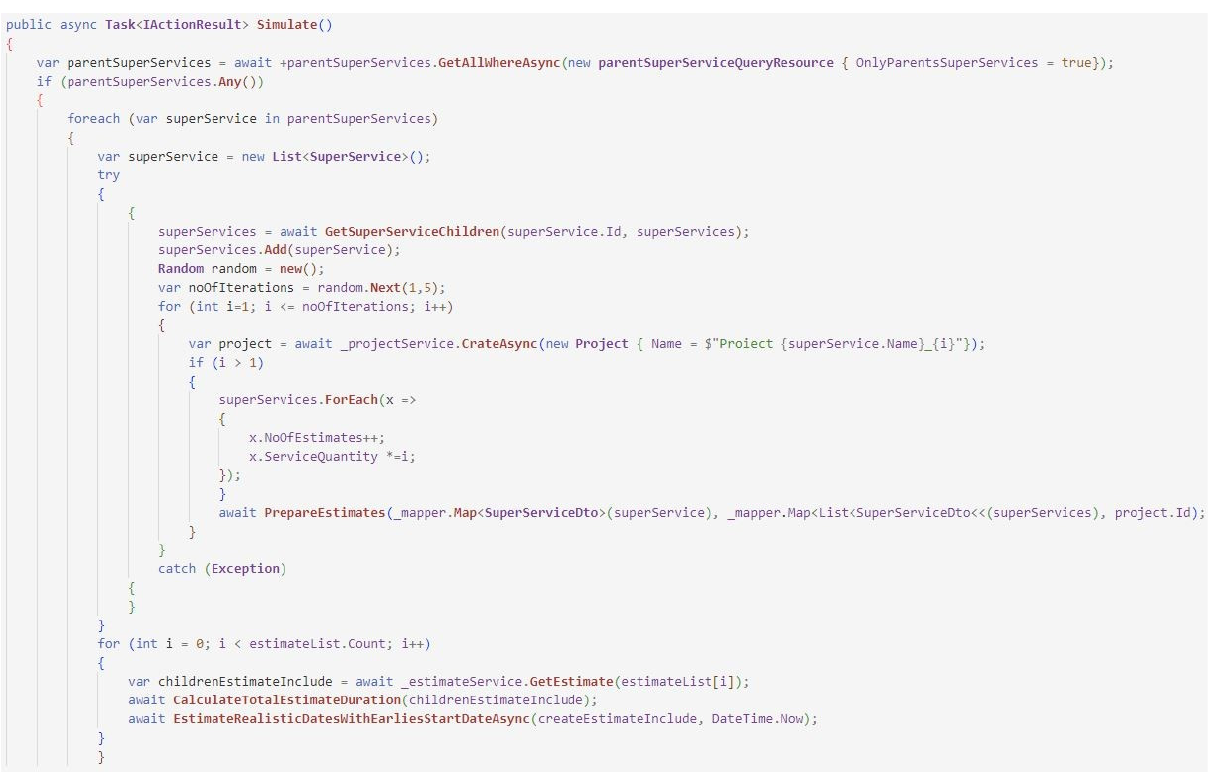
Figure 9. Pseudocode example dedicated to the implementation of services.